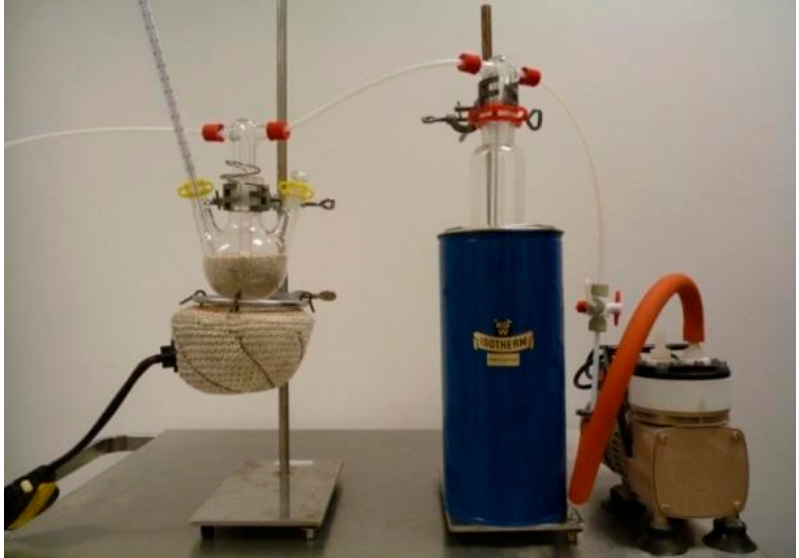
Figure 4. Condensation unit for the recovery of [ 18 O]-water from azeotropic mixtures.